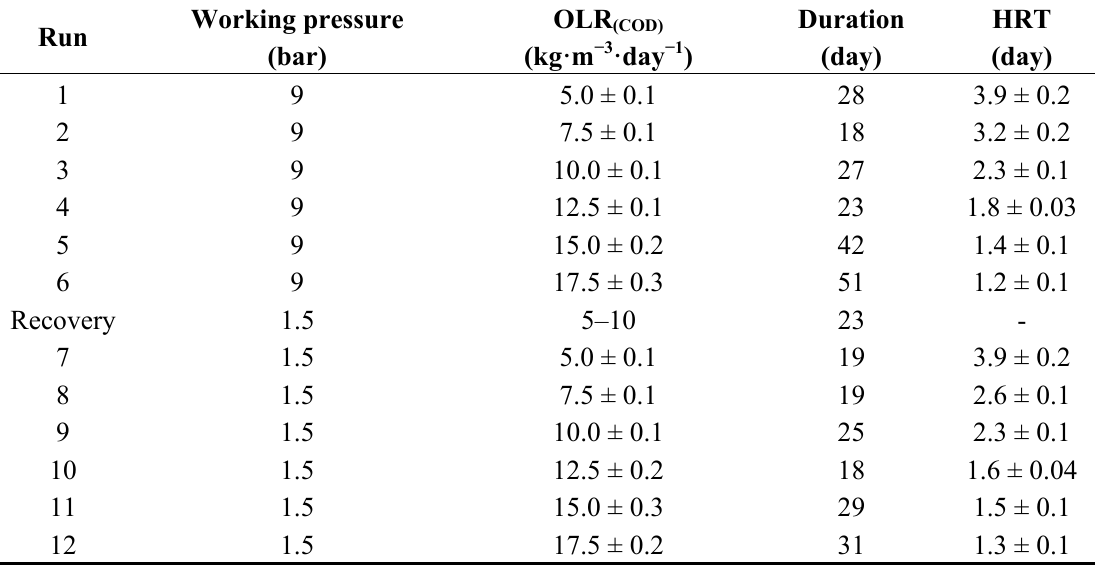
Table 2. Experimental